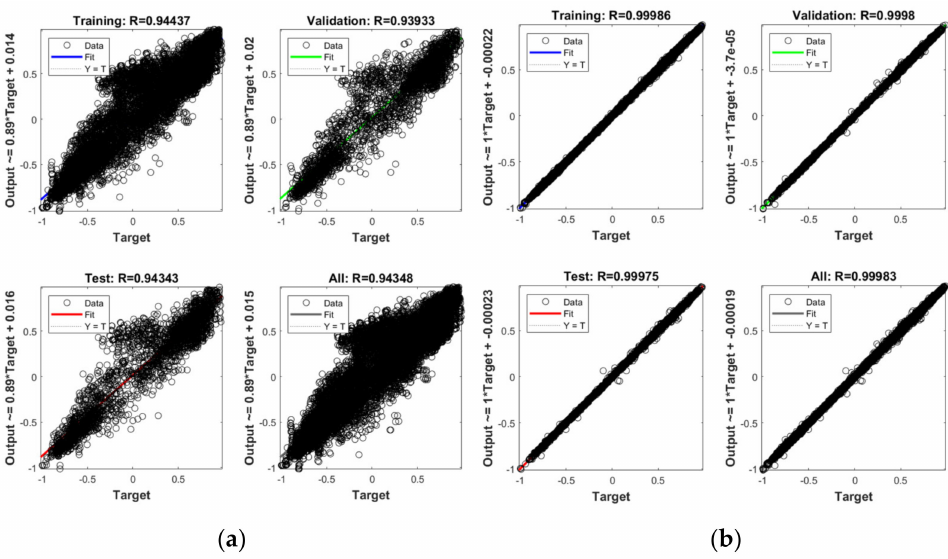
Figure 5. The training results of different neural networks: ( a ) MLNN; ( b )